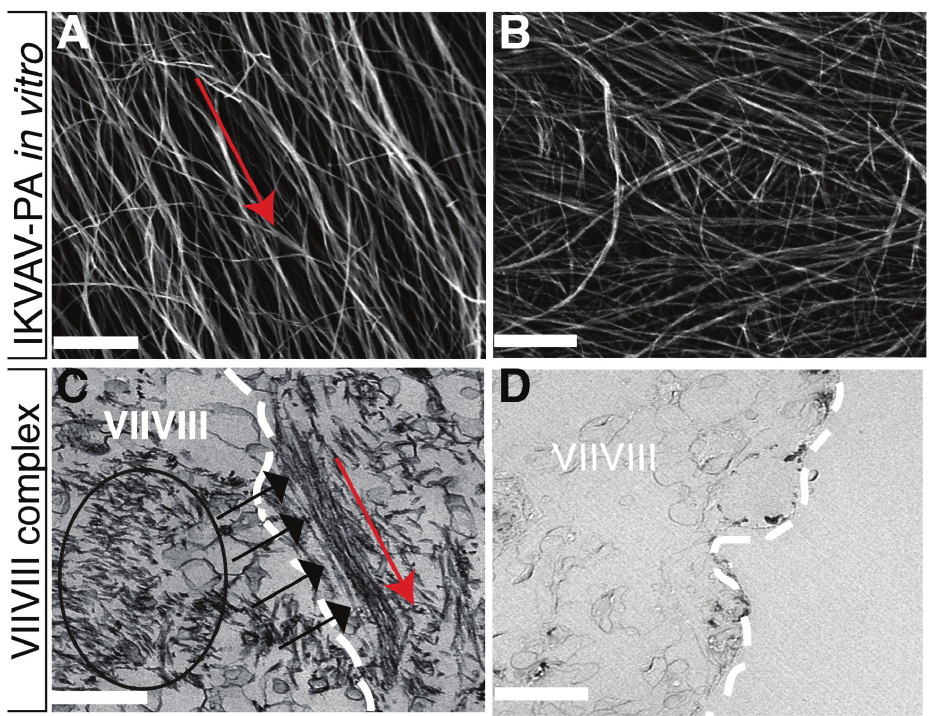
Fig 7. Electron microscopy study of IKVAV-PA gels in vitro and ex vivo human cadaveric tissue. ( A ): SEM image of alignedIKVAV nanofibersin vitro (note predominantorientation in the directionof the shear force, indicatedby red arrow). Scale bar = 1 μ m. ( B ): Non-alignedIKVAV nanofibersin vitro showinga randomly orientedconfiguration due to fluid turbulence. Scale bar = 1 μ m. ( C ): TEM image of self-assembled IKVAV-PA gel overlyingthe facial-vestibulocochlear nerve complex (indicatedby a black circle and black arrows) followingendoscopic transmastoidinjectioninto the modiolus.Note the parallelalignmentof self- assembled peptides indicatedby the red arrow (11,000 × magnification). Scale bar = 1 μ m. ( D ): Controlnerve specimen with no evidenceof peptidescaffold for comparison(1,900 × magnification). Scale bar = 1 μ m. Note putative epineuriumof the facial-vestibulocochlear nerve complex indicatedby the white dotted line (C & D). Abbreviations: VIIVIII: facial-vestibulocochlear nerve complex.